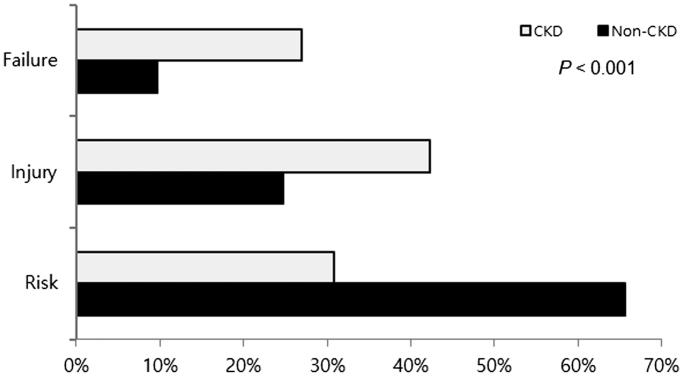
The comparison of AKI according to the RIFLE category in patients with CKD and non-CKD.